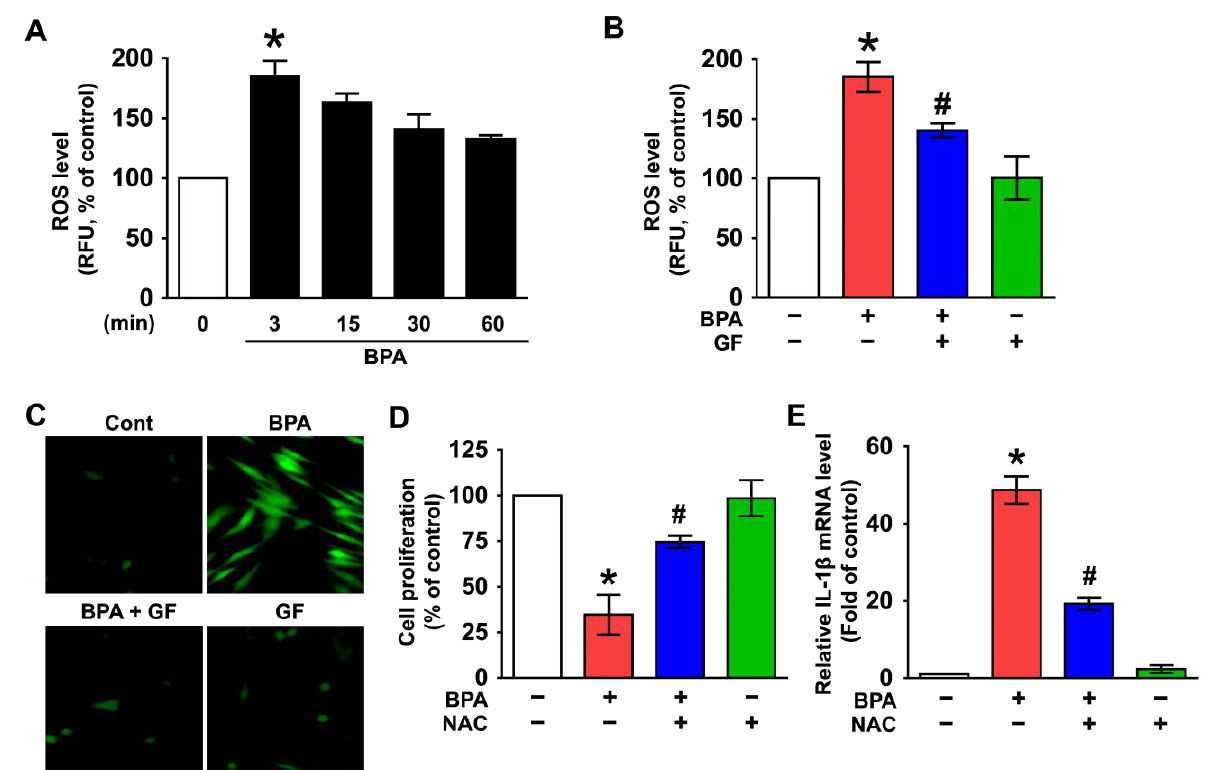
Figure 2. GF contains anti-oxidative components that scavenge the intracellular ROS caused by BPA. ( A ) Time-dependent responses of reactive oxygen species (ROS) production in NHDFs treated with BPA are shown. The level of ROS was determined by staining NHDFs with CM-H 2 DCFDA. n = 4. * p ≤ 0.05 vs. 0 min. ( B ) NHDFs were co-treated with GF and BPA for 3 min. n = 4. * p ≤ 0.05 vs. control. # p ≤ 0.01 vs. BPA alone. RFU, Relative fluorescence units. ( C ) The blocking effects of GF on ROS production (green) confirmed by confocal microscopy are shown. Scale bars, 100 µ m (magnification × 100). n = 3. NHDFs were pretreated with 1 µ M of N-acetylcysteine (NAC) for 30 min prior to BPA treatment for 6 h. The level of cell proliferation ( D ) and IL-1 β mRNA ( E ) is shown. * p ≤ 0.01 versus control. # p ≤ 0.01 vs. BPA alone. n = 3.